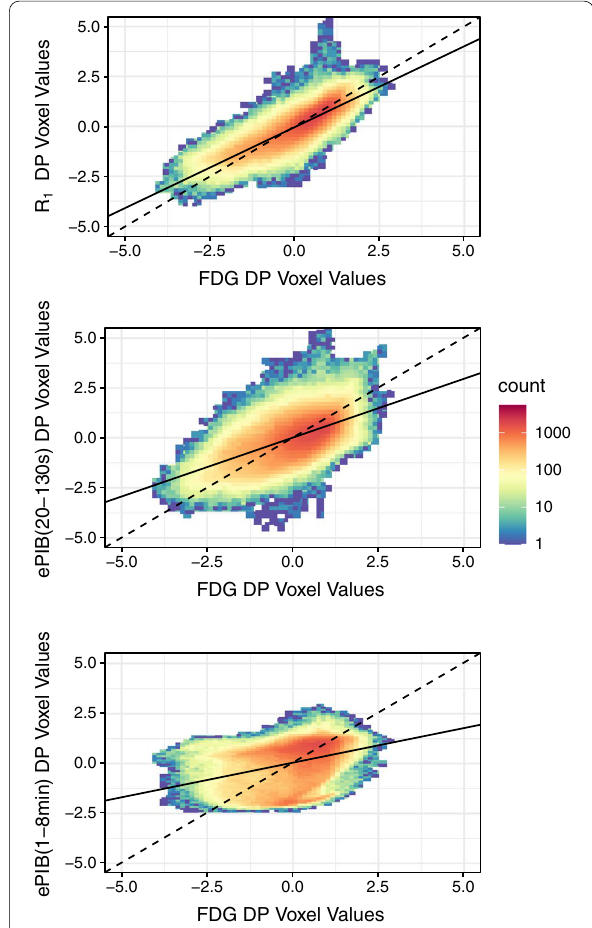
Fig. 2 Joint Histograms of the disease patterns . Joint histograms of the FDG and R1 (top), ePIB(20–130 s) (middle), and ePIB(1–8 min) (bottom) DPs. The dashed line corresponds to the identity, and the solid line, to the linear regression of the data from the DPs. The bin counts are displayed in base 10 logarithmic amplitude scale